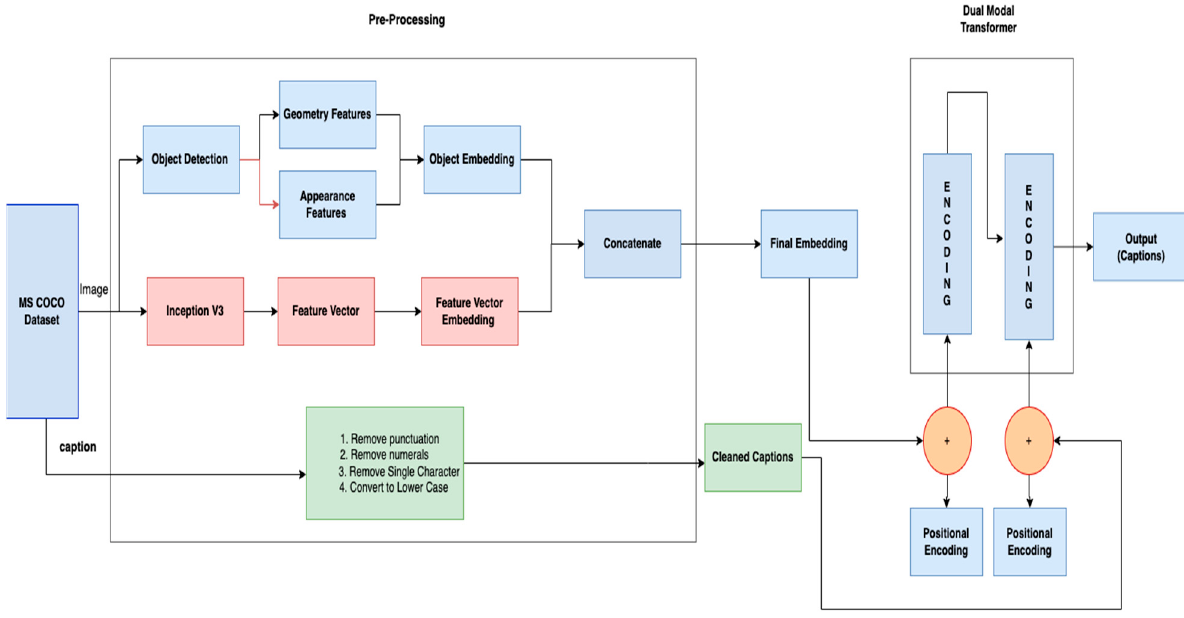
Figure 1. Workflow for Image Captioning Using Dual-Modal Transformer.